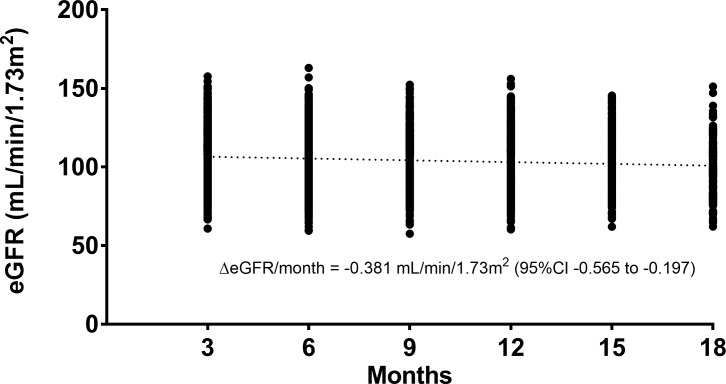
Estimated glomerular filtration rate (eGFR) at each follow-up period by individual patient, measured from time of enrolment.Trend line derived by linear regression (p<0.001).